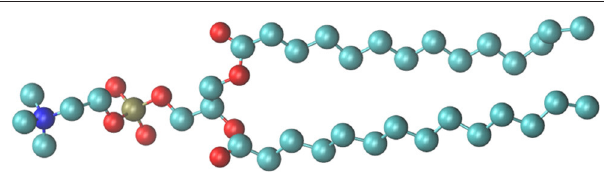
FIGURE 1 | The DMPC model used for the simulations. Oxygen atoms are colored red, the phosphorous gold and nitrogen of the choline group blue.